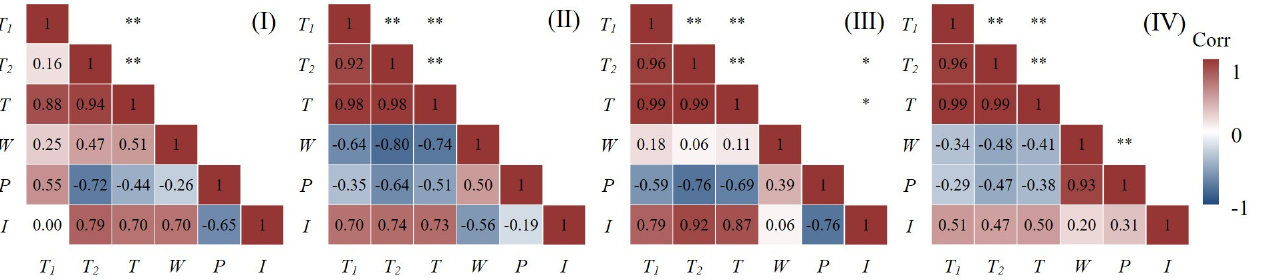
Figure 8. Correlation heat map of meteorological conditions in different farming types. “*” indicates significant correlation at the 0.05 level. “**” indicates significant correlation at the 0.01 level. ( I ) Hebei, Shandong, and Henan low-lying plains. ( II ) pre-mountain plain area in Yanshan and Taihang Mountains. ( III ) Huang-Huai plain area. ( IV ) Shandong hilly area.